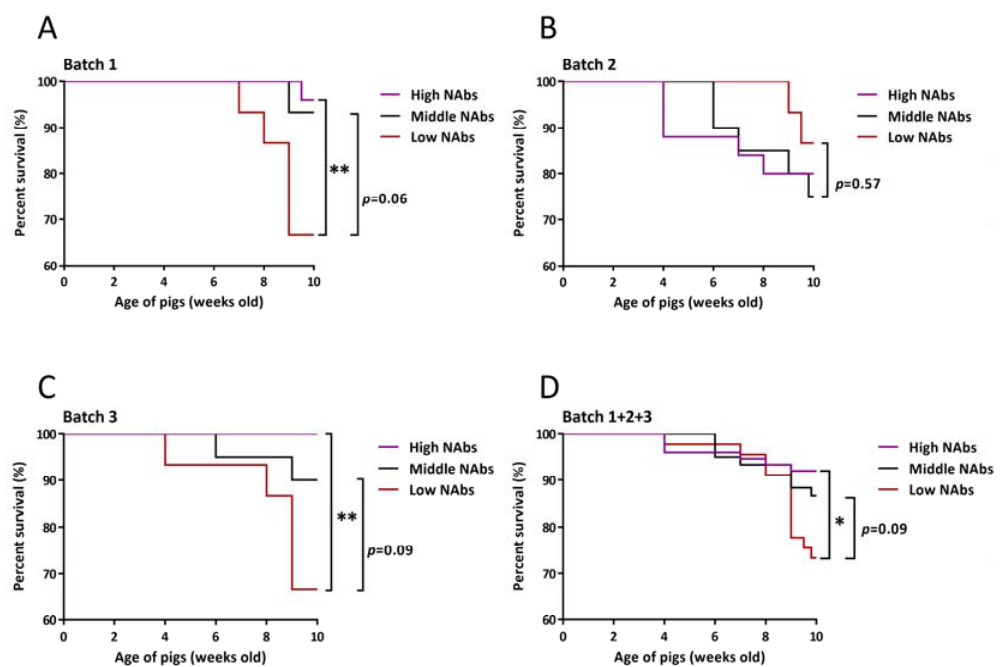
Figure 6. Survival curves of each group in different batches ( A – D ). Data for dead pigs were evaluated daily. The survival rates in the high and low NAbs groups were presented, 96% and 67% in batch 1, 80% and 87% in batch 2, 100% and 67% in batch 3, and 92% and 73% in batch 1+2+3, respectively. * and ** indicate significant differences, p < 0.05 and p < 0.01,